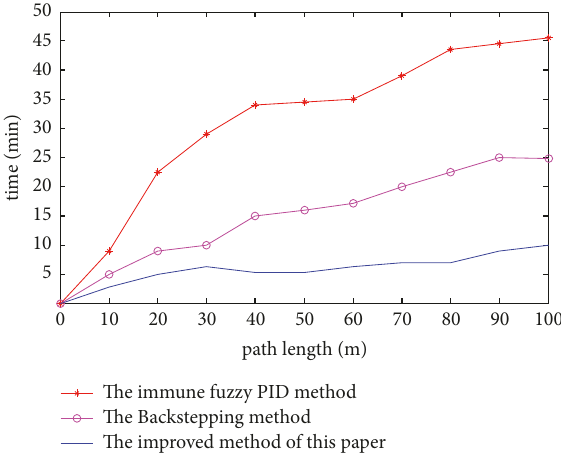
Figure 3: The shortest path of immune fuzzy PID method.